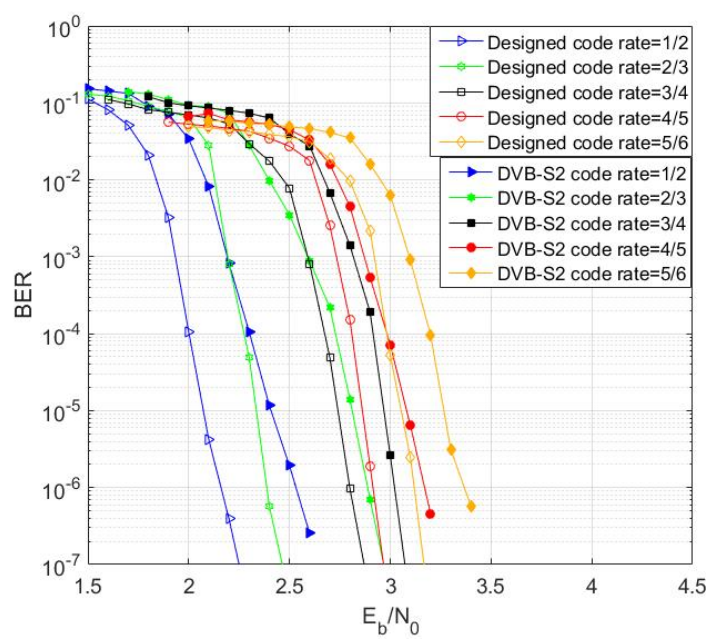
Figure 15. BER simulation comparison result.